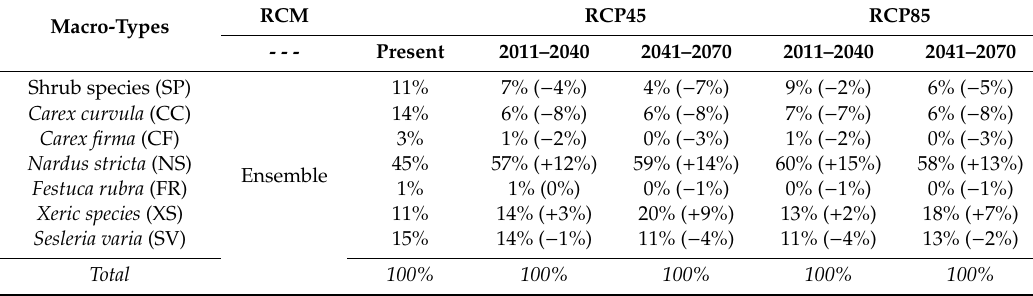
Table 5. Current and expected Alpine pasture composition (%) for 2011–2040 and 2041–2070 under RCP4.5 and RCP8.5 as resulting from the modeling ensemble. In brackets, changes for each macro-type compared to the present.